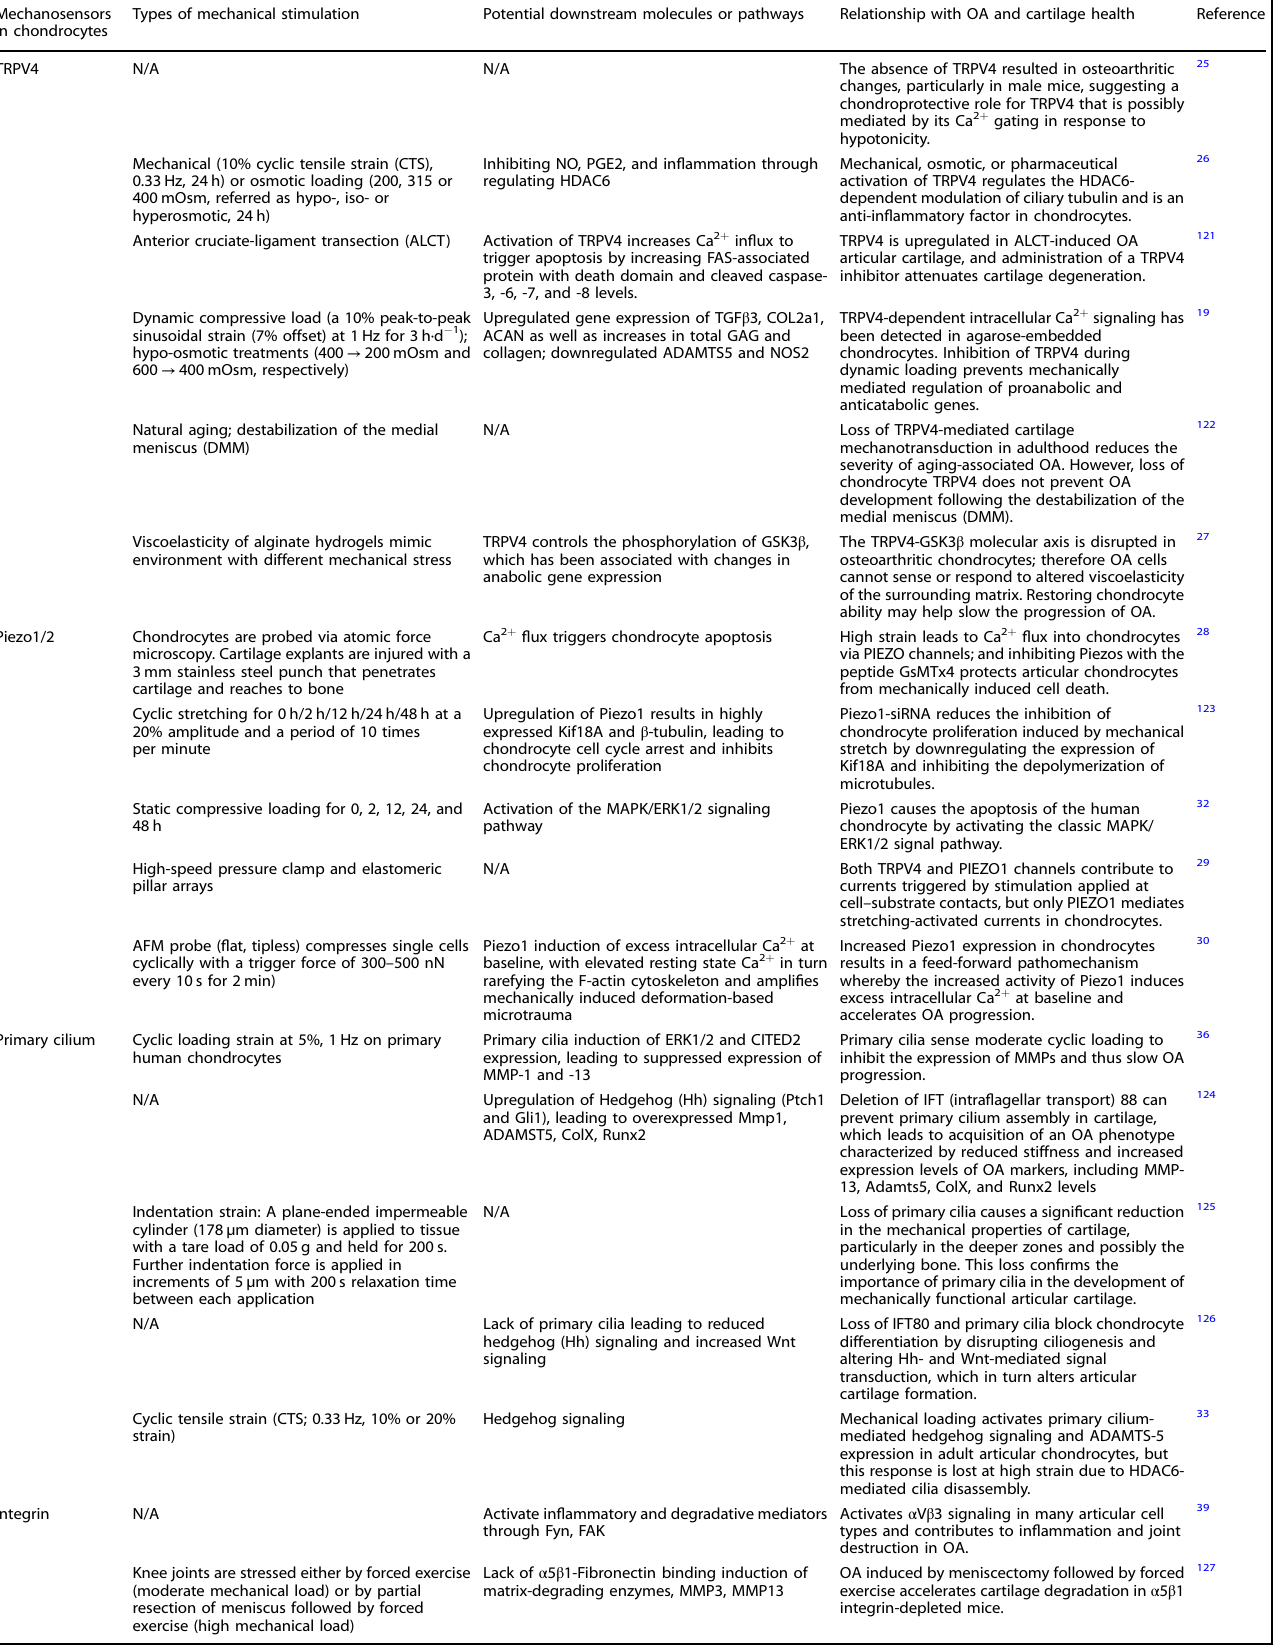
Table 1. List of known mechanosensors in chondrocytes and their potential downstream genes and pathways Mechanosensors Types of mechanical stimulation Potential downstream molecules or pathways Relationship with OA and cartilage health in chondrocytes